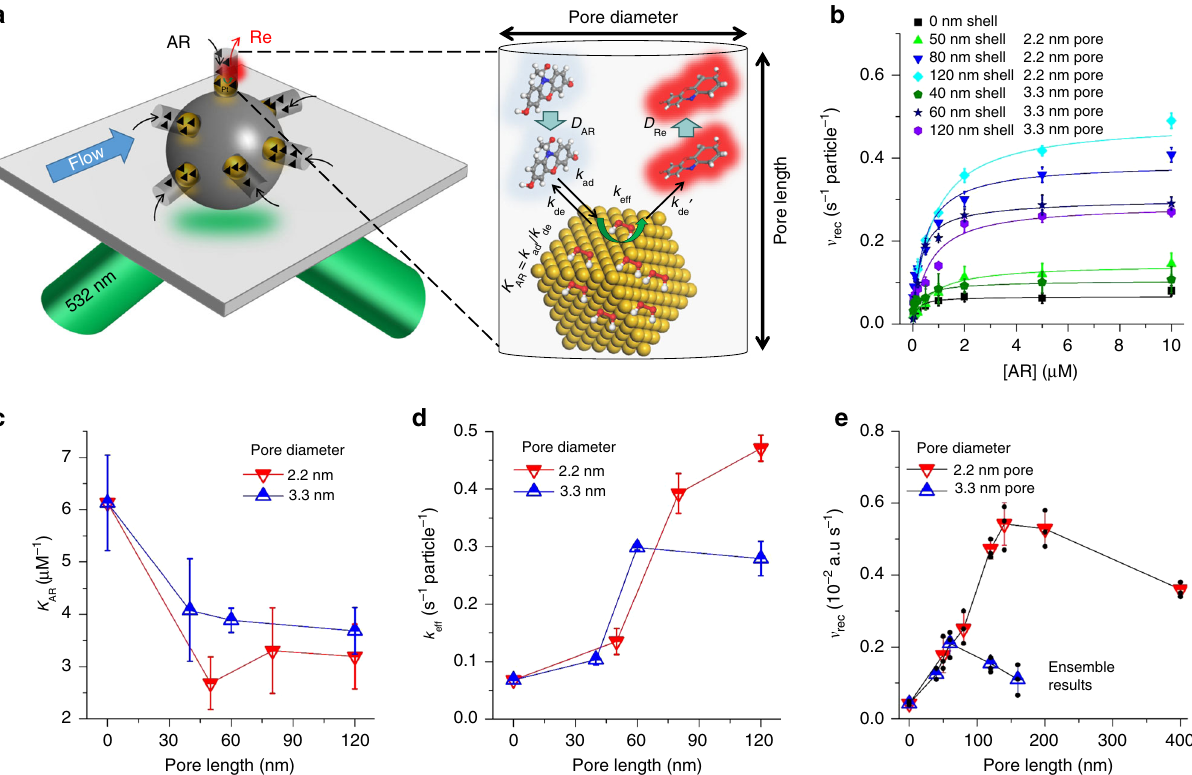
Fig. 1 Reaction kinetics in con fi ning materials with variable nanopore morphologies. a Schematic of single-particle single-molecule imaging setup (left) and chemical conversion processes inside nanopore (right). b Reaction kinetics for different nanopore lengths and diameters at single particle single molecule level. Adsorption/desorption equilibrium constant K AR c and rate constant k eff d are obtained from fi tting the single particle single molecule kinetics data with the DLH model. e Ensemble results of reaction rates of nanocatalysts with variable porous shell thickness and pore diameter are shown at same amount of particle concentrations (~10 12 particles mL − 1 ). It should be noted that the shallow excitation depth of TIRFM (<250 nm) makes it challenging to compare single particle catalytic activities of thicker shells (>150 nm) to those with thin shells (40 – 120 nm) quantitatively. The error bars are calculated uncertainties from fi tting catalytic reaction kinetic data over 40 single nanocatalysts for each nanopore morphology ( b and c ) and calculated standard deviation (s.d.) from three trials of ensemble measurements ( e ),